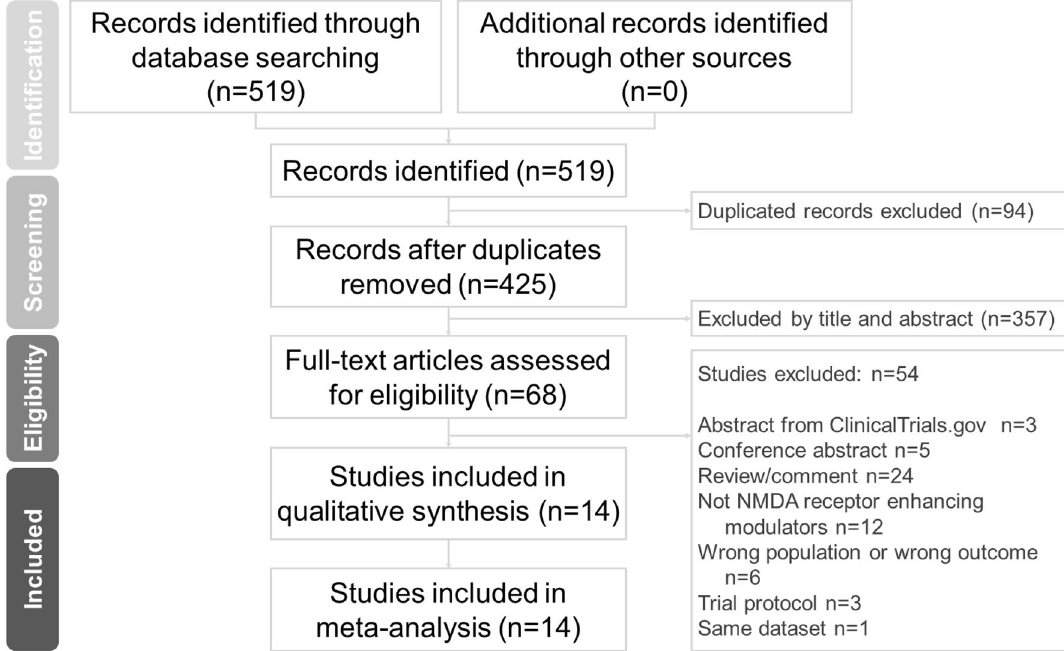
Figure 1. PRISMA flow diagram of the search and identification of included studies. Database: PubMed (n = 304), Cochrane Central Register of Controlled Trials (n = 208), Cochrane Database of Systematic Reviews (n = 7). Keyword: (Dementia OR Alzheimer*) AND (acetylcysteine OR α-amino-3-hydroxy-5-methyl-4- isoxazolepropionic acid OR AMPA OR benzoate OR CX516 OR D-cycloserine OR D-serine OR glutamine OR glutamate OR glutamate carboxypeptidase 2 OR GCP2 OR glycine OR glycine transporter type 1 OR GlyT1 OR glutamate receptor ionotropic kainate OR GRIK OR kynurenine aminotransferase OR KAT OR metabotropic glutamate receptor OR mGluR OR minocycline OR N-acetyl-aspartylglutamate OR NAAG OR N -methyl-d- aspartate OR NMDA OR pregnenolone OR sarcosine) AND controlled trial. Date: date available to August 7th,